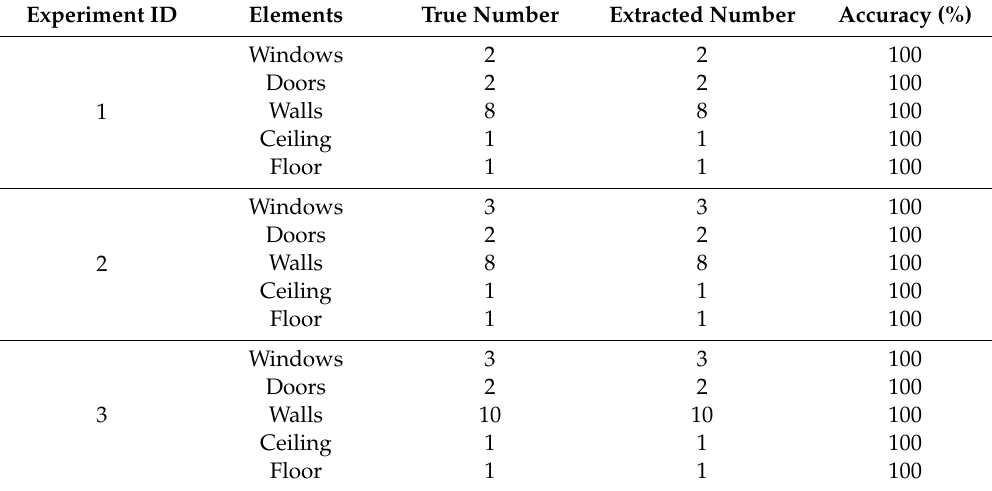
Table 2. The element extraction results of the proposed